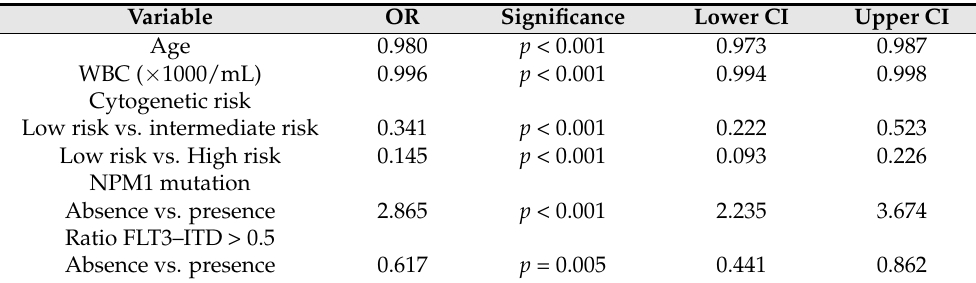
Table 3. Factors associated with response to induction therapy. Multivariate regression logistic for response to induction treatment. Effect of patient and disease characteristics on best response to treatment (complete remissions) and multivariate analyses (prognostic factors with p < 0.1 in univariate analysis were